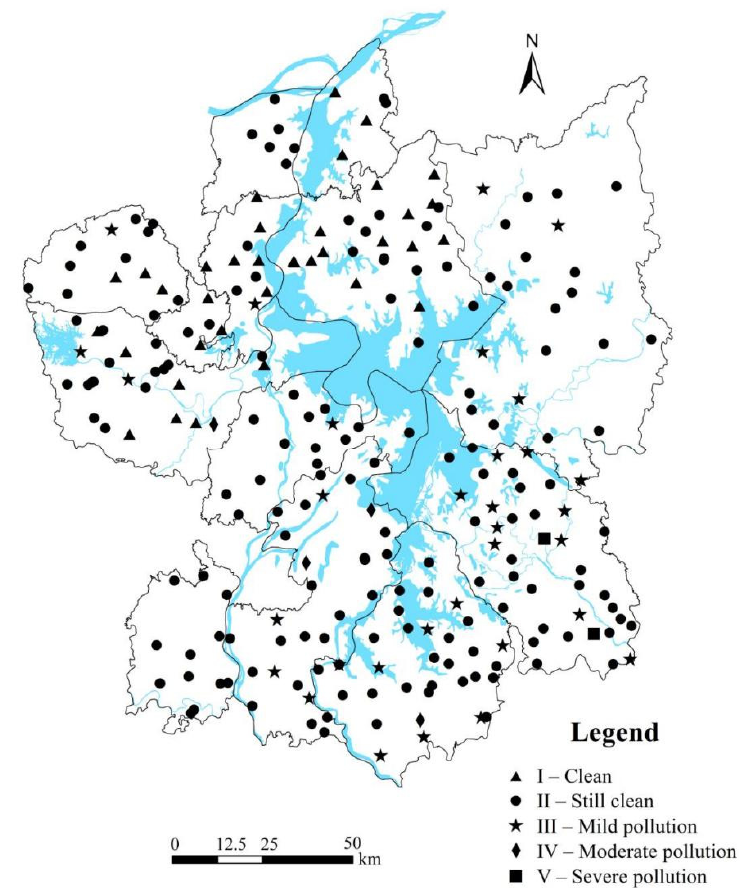
Figure 3. Spatial distribution of the pollution levels of potential toxic elements in cultivated soils at different sampling points.